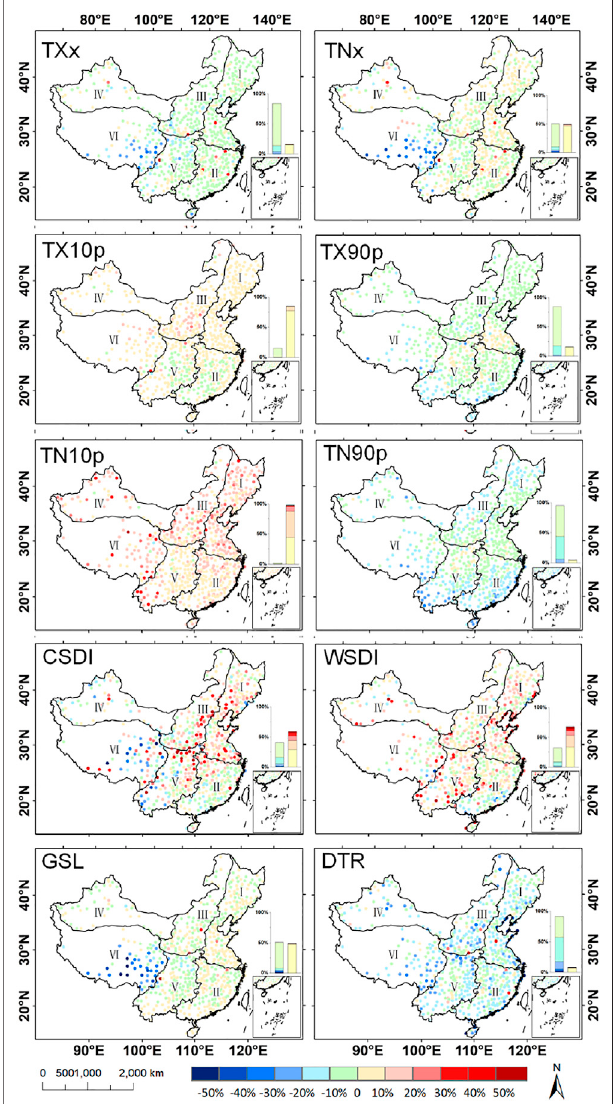
FIGURE 4 | Spatial distribution of RB for extreme temperature indices of ERA5 over